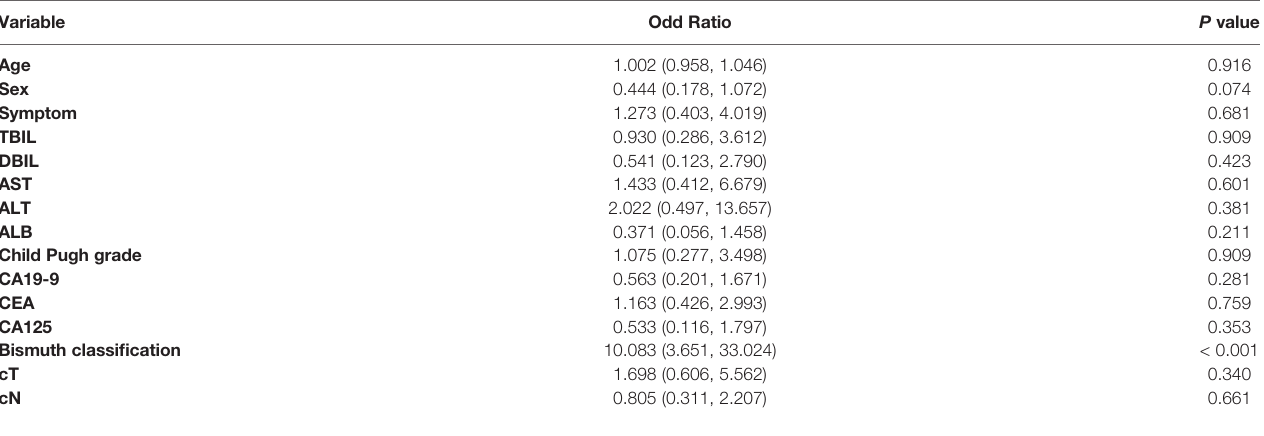
TABLE 2 | Univariate logistic regression in the training cohort.